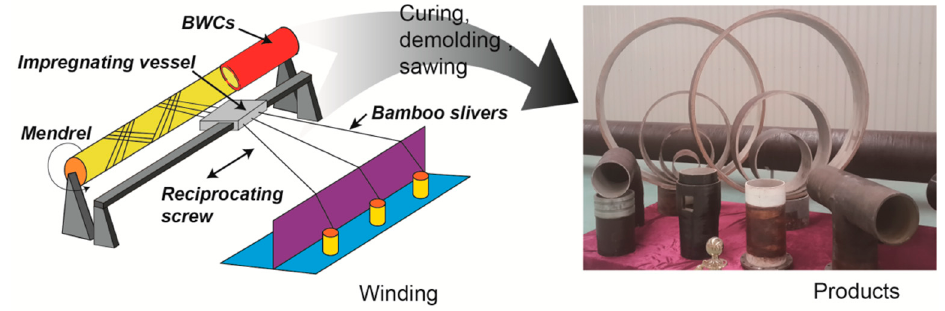
Figure 2. Processing and products of BWC pipes winding with bamboo slivers.